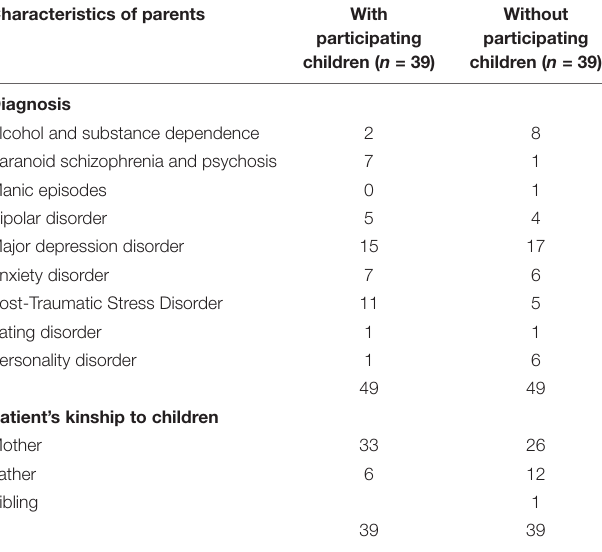
TABLE 1 | Characteristics of parents with participating and non-participating